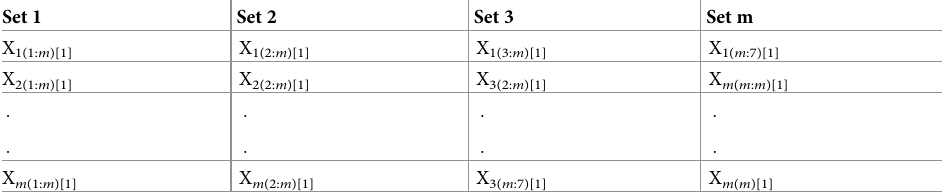
Table 1. Sample layout of 1 st cycle of imperfect ranked set sampling procedure. Set